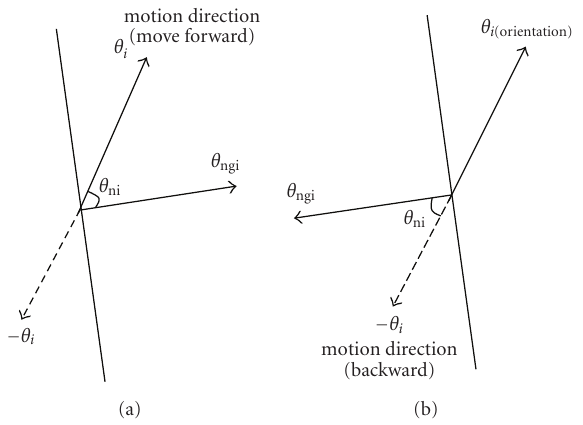
Figure 5: (a) The robot forward direction has a positive projection on the negative gradient direction; the robot will move forward to guarantee the θ ni is in the set [ − π/ 2, π/ 2]. (b) The robot backward direction has a positive projection on the negative gradient direction; the robot will move backward to guarantee that the θ ni is in the set [ − π/ 2, π/